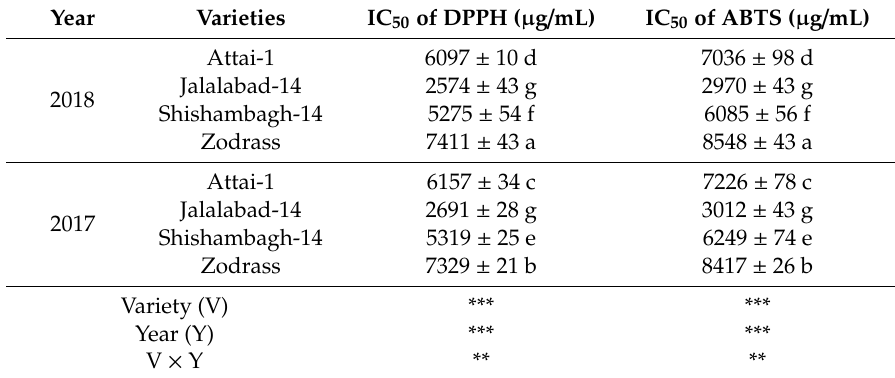
Table 6. Antioxidant activities of rice grain in terms of IC 50 inhibition in selected rice